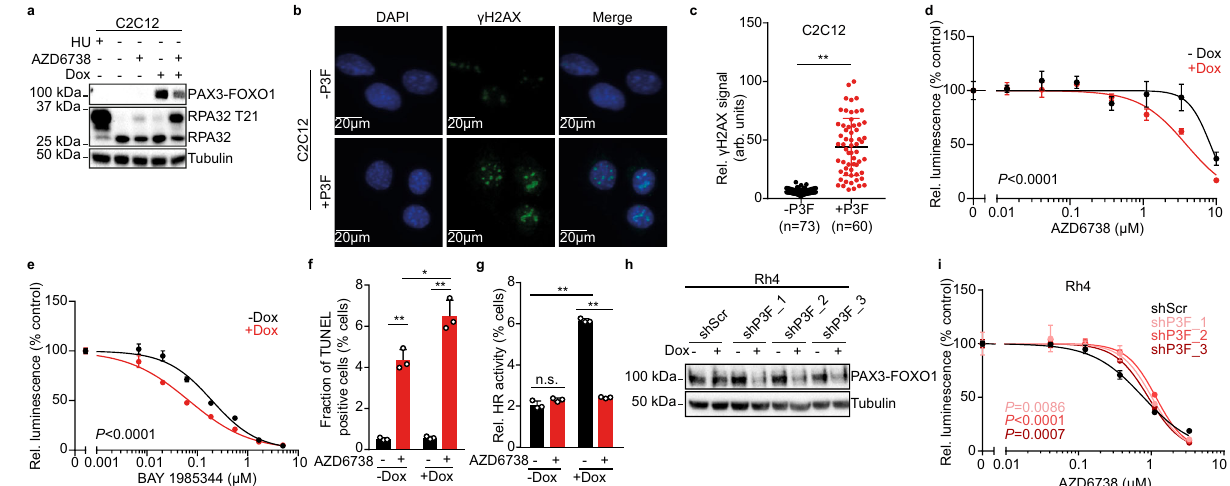
Fig. 4 | PAX3-FOXO1 is suf fi cient to increase sensitivity to ATR inhibition in myoblast cells. a Western immunoblot of PAX3-FOXO1 and RPA32 phosphoryla- tion at T21 in C2C12 after doxycycline-induced expression of PAX3-FOXO1 (1000ng/ml for 48h) and treatment with AZD6738 (750nM). Hydroxyurea (HU, 1mM)wasusedasacontrolforreplicationstress. b RepresentativeimagesofH2AX phosphorylation in C2C12 cells after ectopic expression of PAX3-FOXO1. c Quanti fi cationofH2AXphosphorylationinC2C12cellsafterectopicexpressionof PAX3-FOXO1( P =9.57×10 − 26 ).Dose-response curvesofcellviabilityforC2C12cells after ectopic expression of PAX3-FOXO1 and incubation with AZD6738 ( d ) or BAY 1895344( e )( n =3) .f Quanti fi cationofTUNELsignalinC2C12cellsafterinductionof PAX3-FOXO1 with doxycycline and treatment with AZD6738 ( n =3; from top to bottom, P =0.016;1.84×10 − 4 ;1.99×10 − 4 ). g Relative HRactivityinC2C12cellsafter